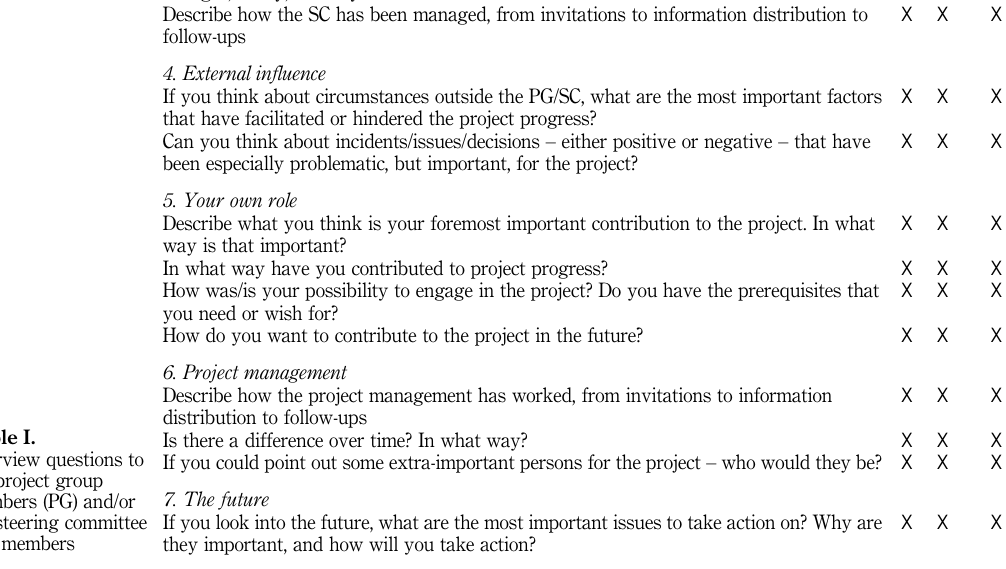
Table I. Interview questions to the project group members (PG) and/or the steering committee (SC)